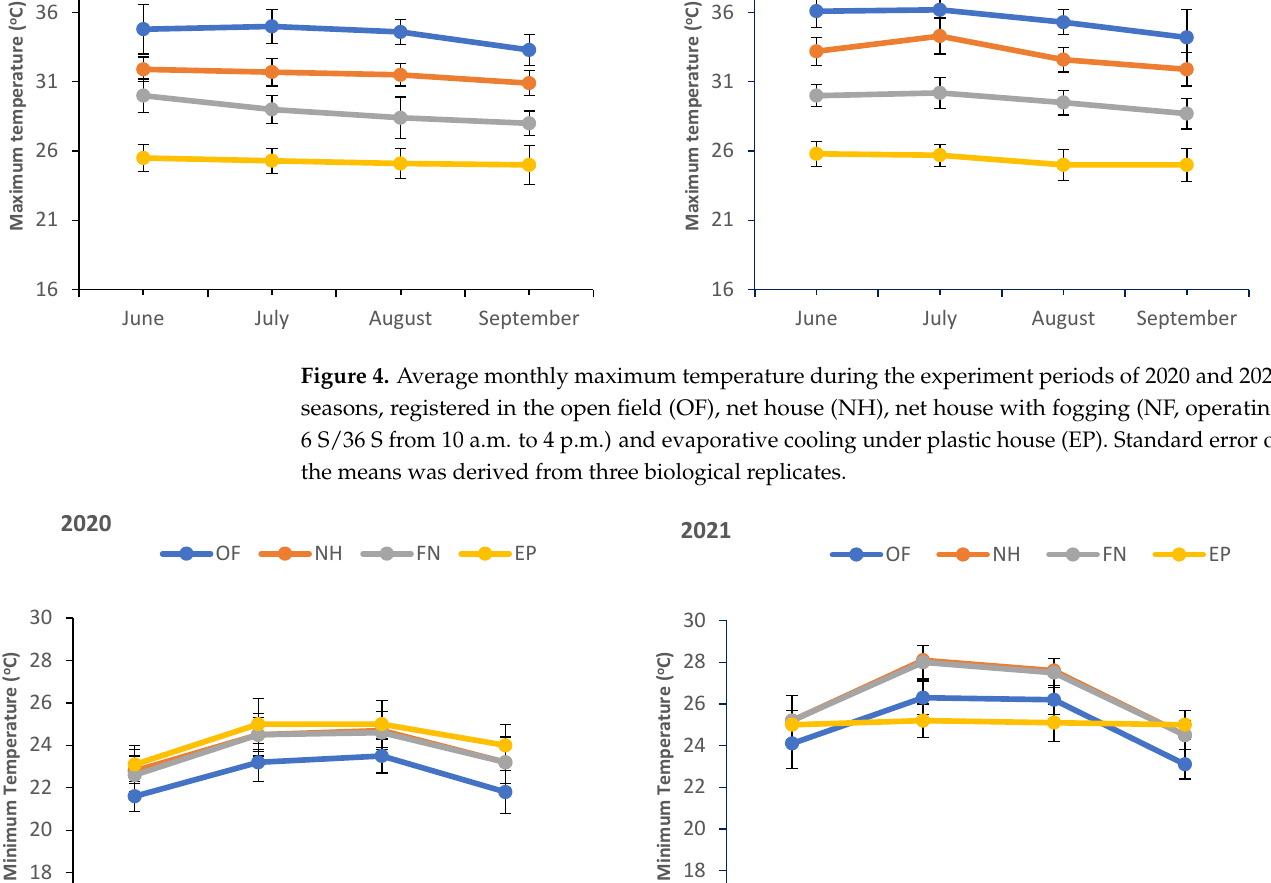
Figure 4. Average monthly maximum temperature during the experiment periods of 2020 and 2021 seasons, registered in the open field (OF), net house (NH), net house with fogging (NF, operating 6 S/36 S from 10 a.m. to 4 p.m.) and evaporative cooling under plastic house (EP). Standard error of the means was derived from three biological replicates.